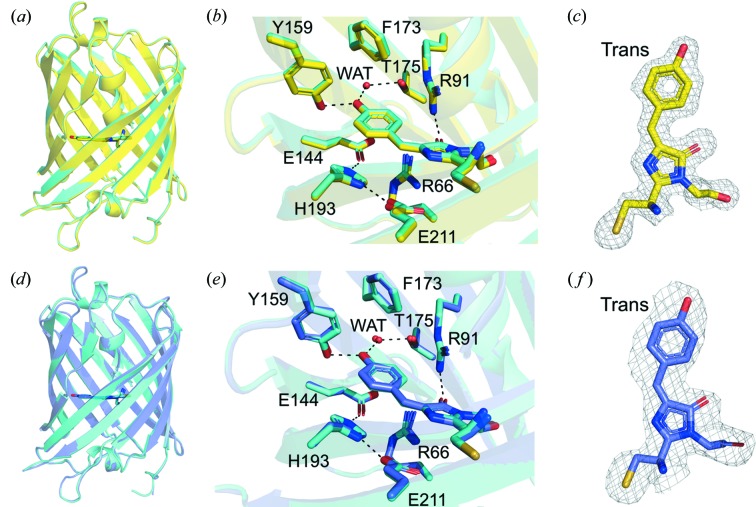
Structure of deuterated Tetdron in the equilibrium state (a–c) and deuterated Tetdron in the ‘off-state’ after 400 nm irradiation (d–f). (a) Structural alignment of deuterated (yellow) and hydrogenated (cyan) Tetdron at equilibrium. (b) Structural alignment close-up of the chromophore site with surrounding residues. (c) Electron density of the chromophore in the trans configuration for deuterated Tetdron at equilibrium. The grey mesh is a 2|F
o|−|F
c| electron-density map contoured at 1σ. (d) Structural alignment of deuterated Tetdron after 400 nm irradiation (‘off-state’, purple), and hydrogenated Tetdron at equilibrium (cyan). (e) Structural alignment close-up of the chromophore site with surrounding residues. (f) Electron density of the chromophore in the trans configuration for deuterated Tetdron after 400 nm irradiation. The grey mesh is a 2|F
o|−|F
c| electron-density map contoured at 1σ.